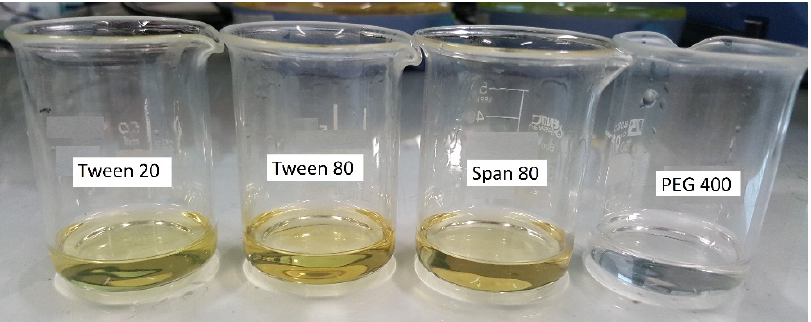
Figure 3. Surfactants evaluated for the enhancement of enzymatic saccharification.